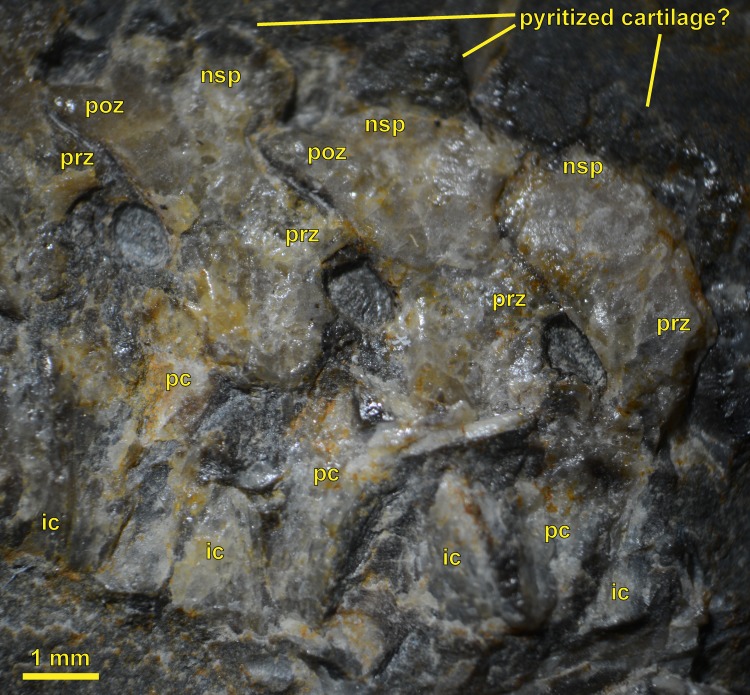
Caudal trunk vertebrae of NMS G 1993.54.1cp, the holotype of Casineria kiddi (counterpart plate), in partly right lateral, partly interior view.The neural arches end dorsally in an ossification front marked by black material (an iron sulfide?) just dorsal to the level of the postzygapophyses, indicating that the individual was immature; the pleuro- and intercentra are reminiscent of those of the anthracosaur Proterogyrinus and the temnospondyl Neldasaurus (Chase, 1965), although their precise shapes are difficult to determine because the vertebrae are split lengthwise and probably recrystallized. Abbreviations: ic, intercentrum; nsp, neural spine; pc, pleurocentrum; poz, postzygapophysis; prz, prezygapophysis. The scale bar is approximate. Photo taken by D. M.